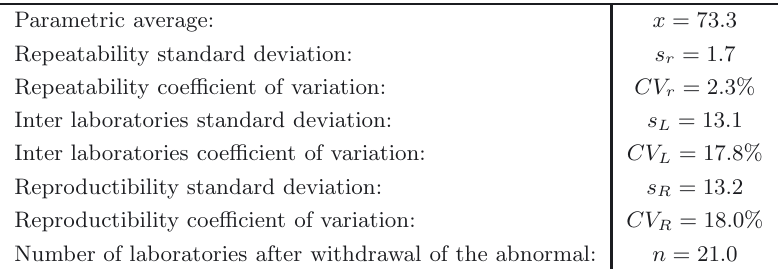
Table 7. Z -score obtained by the laboratories for the his- tamine amount in the level 1 PTS sample. Code lab